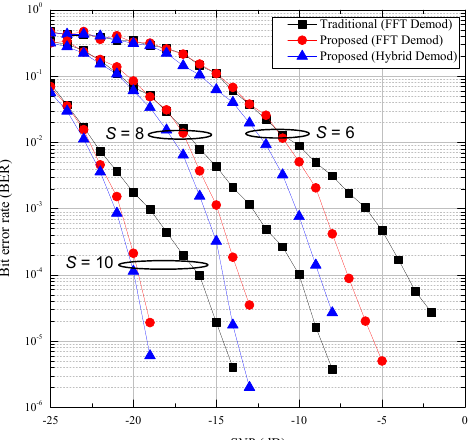
Figure 3. Performance comparison between the proposed and traditional LoRa modulation schemes with different spreading factors. Table 3. SINR (in dB) threshold comparison. Traditional, proposed, and hybrid schemes are presented by green, blue, and red circles, respectively.